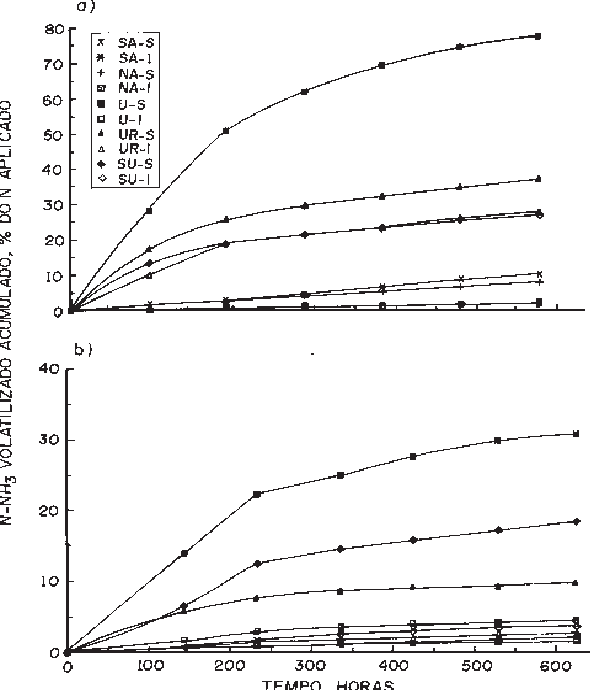
Figura 1. Perdas acumuladas de N-NH 3 , ao longo do tempo, provenientes da aplicação superficial (S) e incorporada (I) de uréia (U), nitrato de amônio (NA), sulfato de amônio (SA), uran (UR) e sulfuran (SU) na cobertura nitrogenada de milho. a: SPD; b: